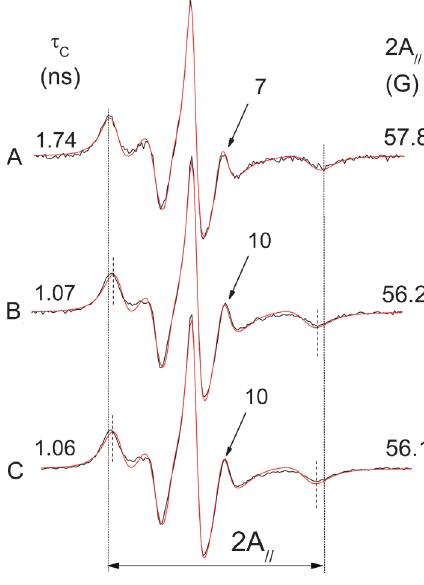
Figure 6. Experimental (black line) and best-fit (red line) EPR spectra of 5-DSA in erythrocyte ghost membranes: A , oxidized with 0.2/2 mM FeSO 4 /H 2 O 2 ; B , pre-treated with 100 m M 4-NC and then oxidized; C , control sample (non-oxidized). The vertical lines help to visualize the EPR parameter 2A // , the value of which is greater for the oxidized sample, indicating a more rigid membrane. The rotational correlation time ( t C ) increased and the relative intensity of the resonance lines, indicated by arrows, decreased with increasing membrane rigidity. EPR: electron paramagnetic resonance; 5-DSA: 5-doxyl stearic acid; 4-NC: 4-nerolidylcatechol.